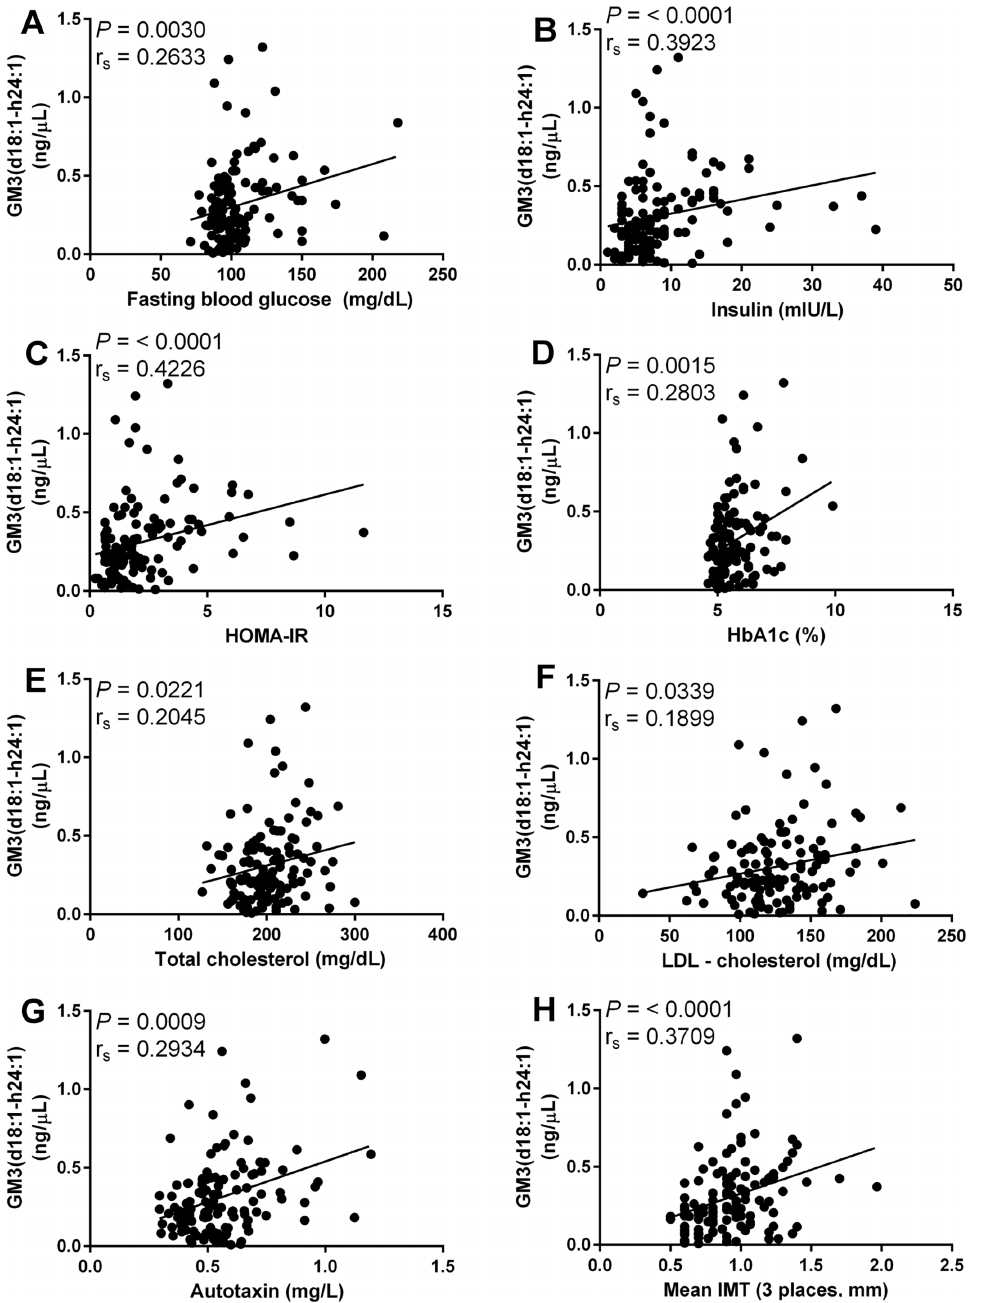
Fig 3. Association between metabolic disease risk factors and GM3(d18:1-h24:1). Correlation of GM3(d18:1-h24:1) with fasting blood glucose (A), insulin (B), HOMA-IR (C), HbA1c (D), total cholesterol (E), LDL-c (F), autotaxin (G) and mean IMT (H). Spearman ’ s rank correlation was used to access correlation between GM3(d18:1-h24:1) and metabolic disease risk factors. All correlations were deemed significant with P values below